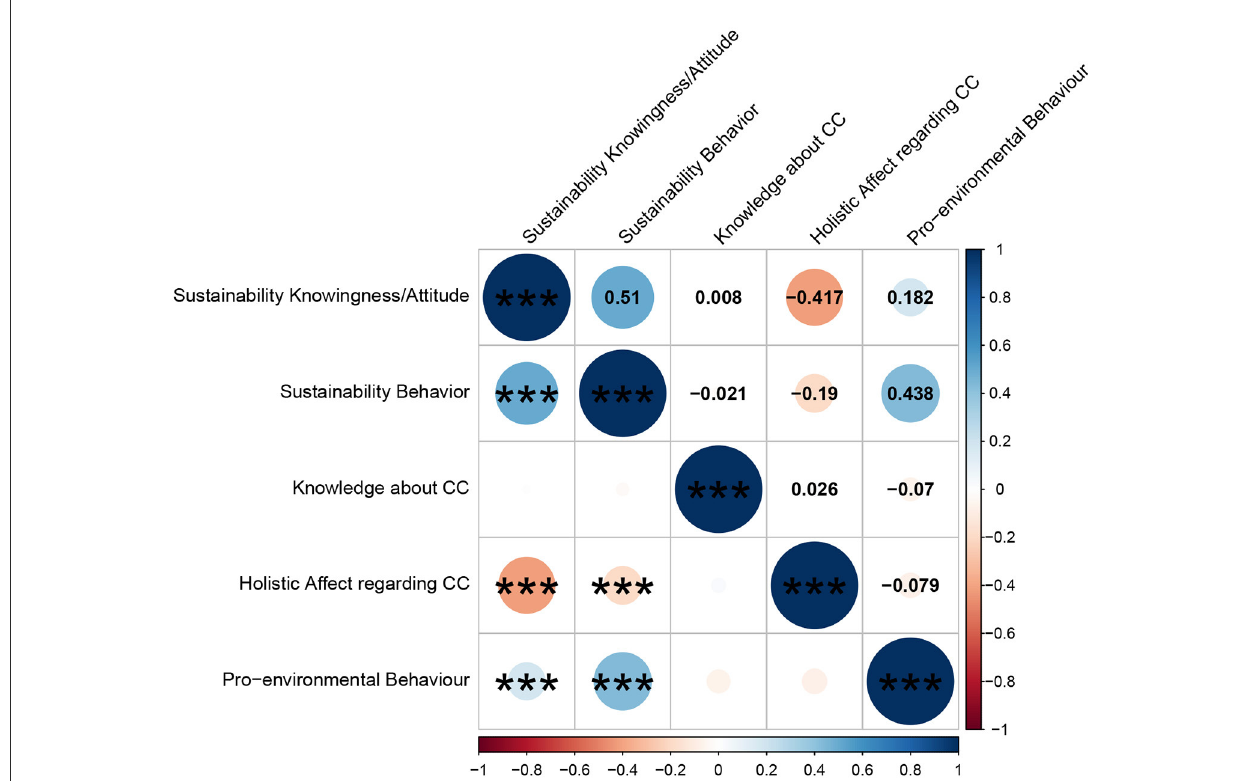
FIGURE6 Correlation matrix between the total score of the sustainability consciousness questionnaire (SCQ) and Climate Change Risk Perception Model scales. Correlation coefficients are shown in the upper triangular matrix and significance values are shown in the lower triangular matrix. The color spectrum indicates the magnitude of the correlation coefficient. For holistic affect regarding climate change, higher scores indicate a more positive evaluation of climate change, while lower scores indicate a more negative evaluation. *** p <